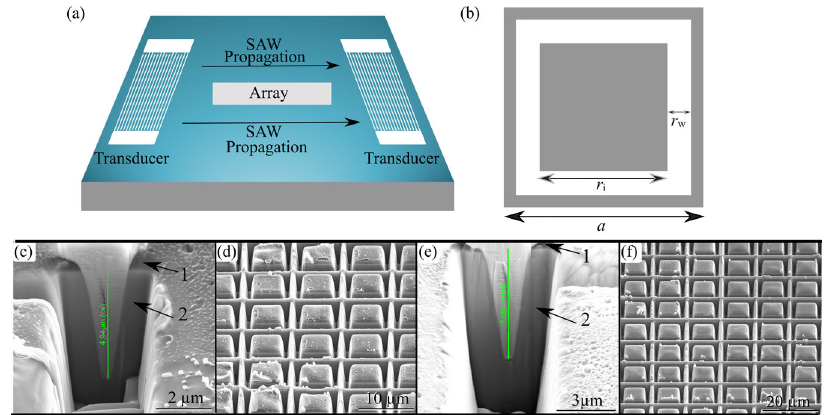
Fig. 5 SAW device con fi guration and array pattern geometries. a The lithium niobate device includes the array patterned between the transducers. To excite a SAW, a transducer terminal was connected directly to the LDV source during characterization using SMA cables and connections. Through this connection, a very low voltage was applied with a 97 MHz frequency. Other transducer terminals were connected to a ground plane as appropriate. b The unit cell of a square annulus. The grey regions are unmilled lithium niobate and the white region of size r w is the area which is focussed ion beam milled to create the annulus. Here a is the lattice constant, r w is the annulus hole width and r i is the internal square dimension. Array#1 and Array#2 were designed with different dimensions so the slow and fast SAW regions, respectively, were positioned at 97 MHz. Focussed ion beam milling was used to pattern the square annulus array into lithium niobate chips. Two patterned devices were fabricated and designed to produce c , d ‘ slow SAWs ’ (Array#1) and e , f ‘ fast SAWs ’ (Array#2) at the desired narrowband transducer frequency 97 MHz. Calibrations were obtained outside of the active SAW region to determine the FIB parameters used to create a c 4.95 µ m and a e 7 µ m depth annulus for the devices to exhibit slow and fast SAWs, respectively at 97 MHz. The fabricated arrays ( d , f ) were FIB milled into the lithium niobate chips between the two interdigital transducers ( a ). Both comprised 8 × 144 unit cells (with 144 unit cells along the direction of SAW propagation). Label ‘ 1 ’ on Fig. c and e shows the PMMA layer and label ‘ 2 ’ shows the lithium niobate region.